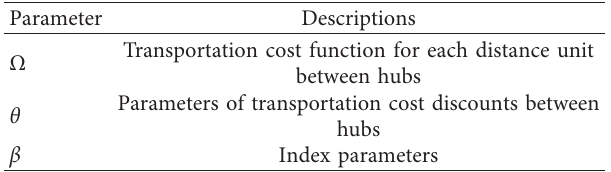
Table 2: The variables used for defining the transportation cost function.